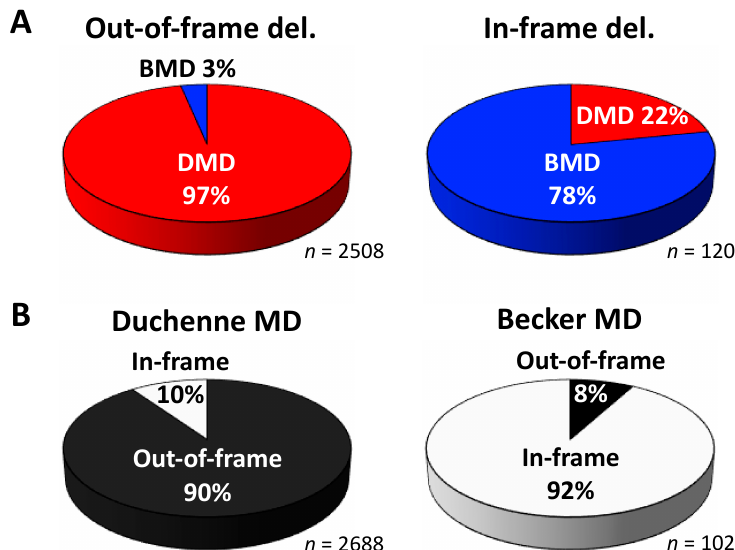
Figure 3. Proportions of phenotypes and frame types in deletion (del.) mutations. The analysis was performed using a total of 3712 patients having deletions arising within the region of exons 2–78 to which the definition of frameshift: out-of- or in-frame is applied. Patients without diagnosis with DMD or BMD were excluded from the analysis. ( A ) “Frame type-based” phenotype ratios indicating that 22% of patients having in-frame deletions are associated with DMD. ( B ) “Phenotype-based” frame type ratios that define the reading frame rule [19,20].